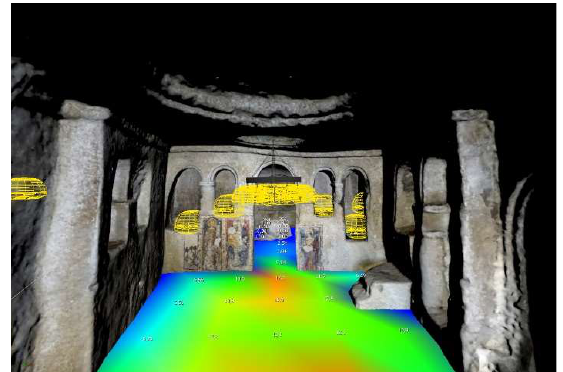
Figure 17: 3D Studio Max Sw. Lightmeter for lighting analysis. Figure 19: 3D Studio Max Sw. Photorealistic render of the nave Natural and artificial lighting in the nave. h 08.00 p.m. - Date: with the chandelier with 6 glass little cups. h 17.00 p.m. - Date: 21 Dec.2018 21 Dec. 2018